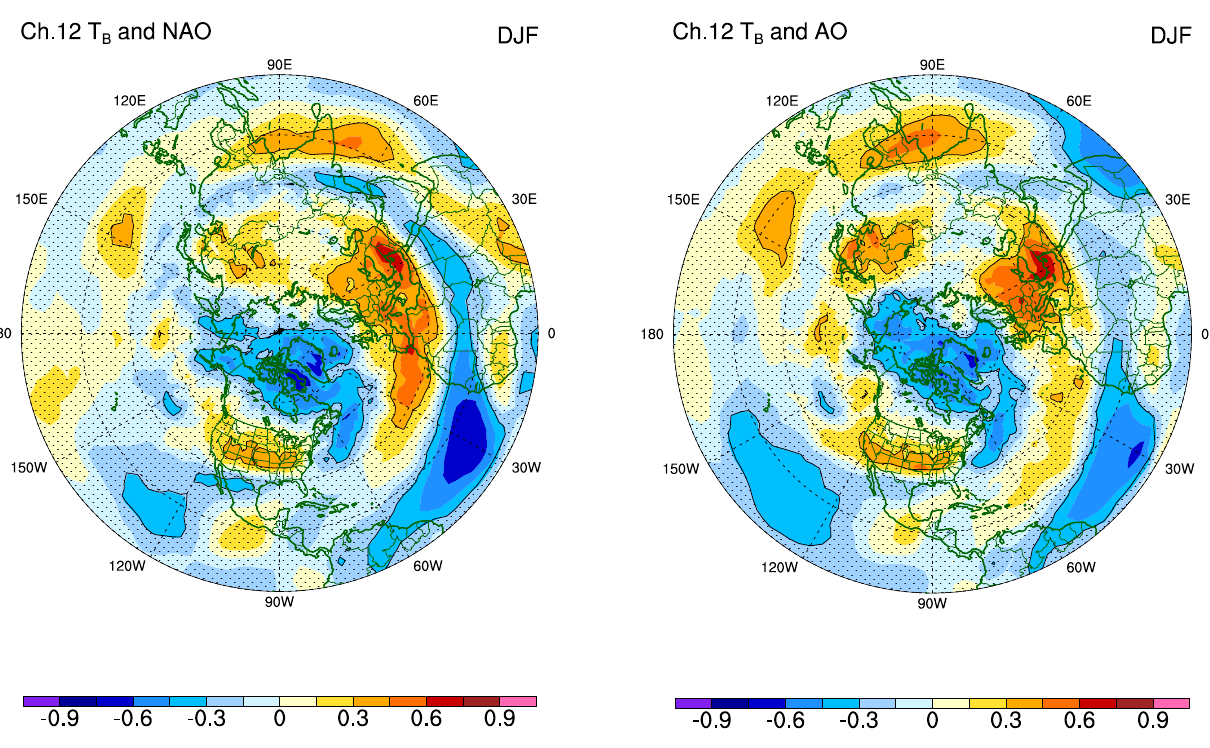
Fig. 11. Same as Fig. 7 for correlations between channel 12 T B and AO